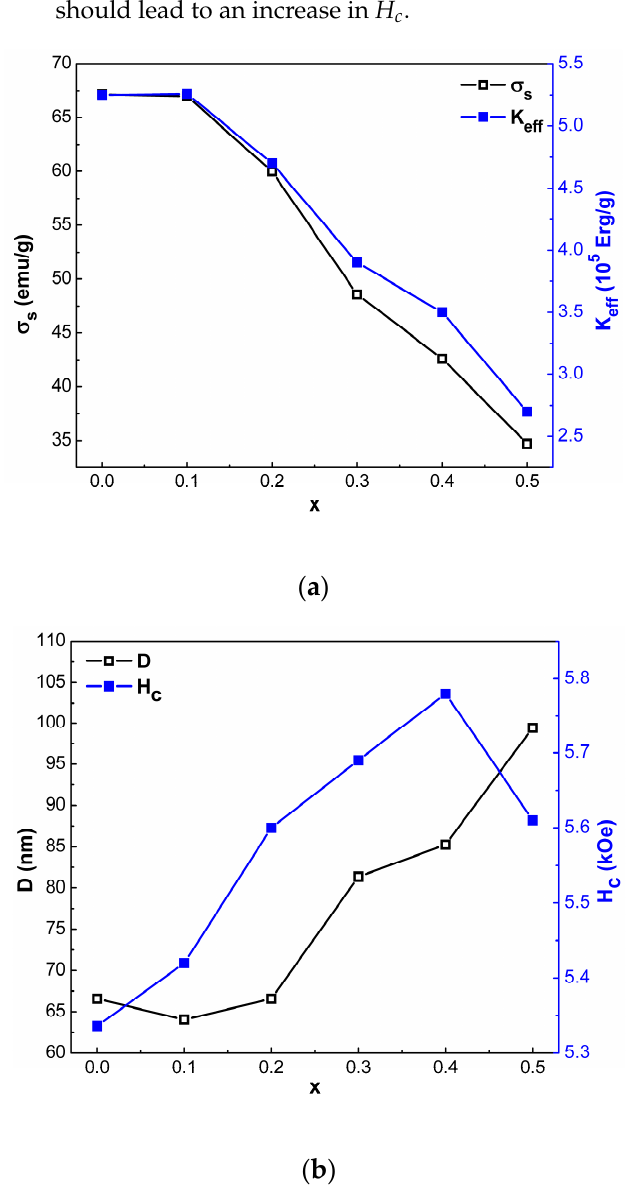
Figure 10. Variation of saturation magnetization and magnetic anisotropy constant ( a ) and crystallite size and coercivity as a function of Nd ( x ) content ( b ) for hexaferrite powders.